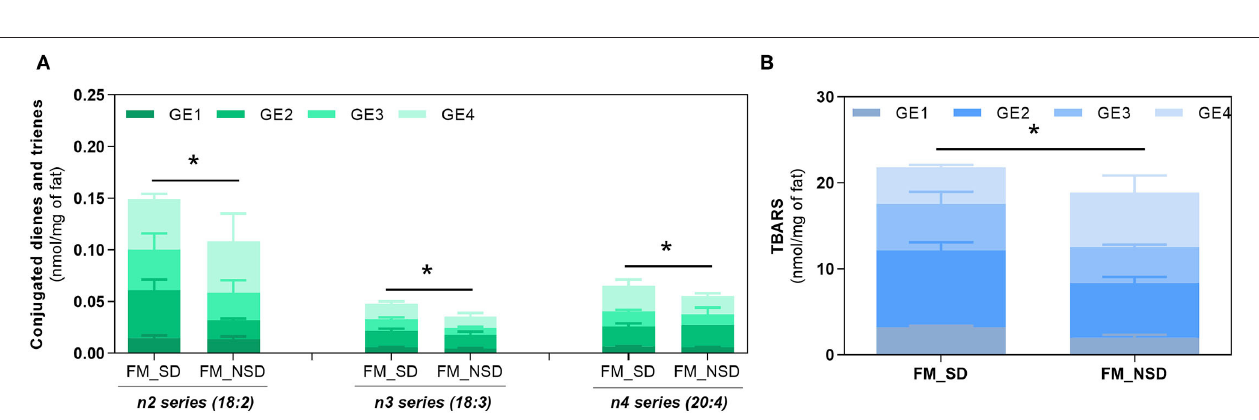
FIGURE 6 | Fat oxidation of fish meal containing sugary drink (FM_SD) vs. fish meal without sugary drink (FM_NSD). Formation of conjugated dienes (CD, n2 series) and conjugated trienes (CT, n3, and n4 series) (A) and TBARS (B) during gastric digestion of FM and FM_NSD. Data are presented as the average ± SD of four replicates ( n = 4). Parametric ( t -test) statistical tests were applied to compare FA oxidation at the end of gastric digestion between FM and FM_NSD meal diets. *Indicate statistical differences ( p < 0.05) between meals.